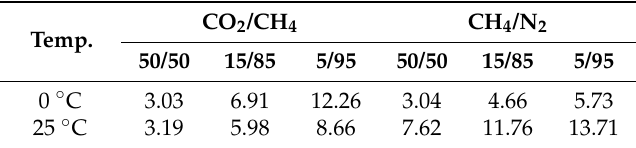
Table 3. The selectivity of N-WAPC for binary mixtures [a] .